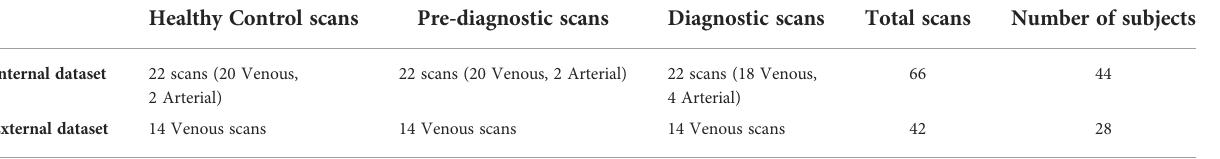
TABLE 1 The table provides the split of the total 108 CT scans used in the